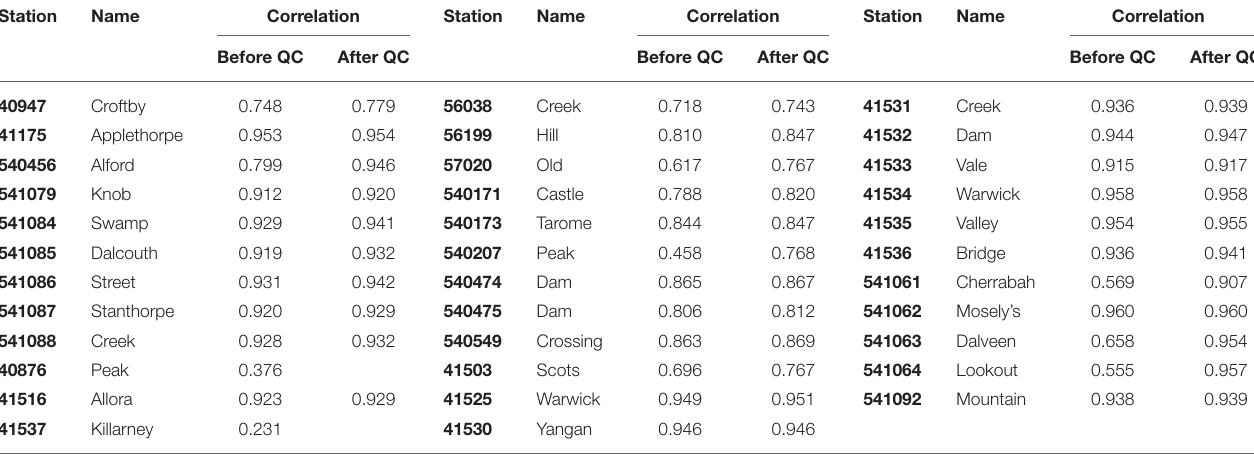
TABLE 2 | Correlation coefficient of rain gauge observations with AWAP. Station